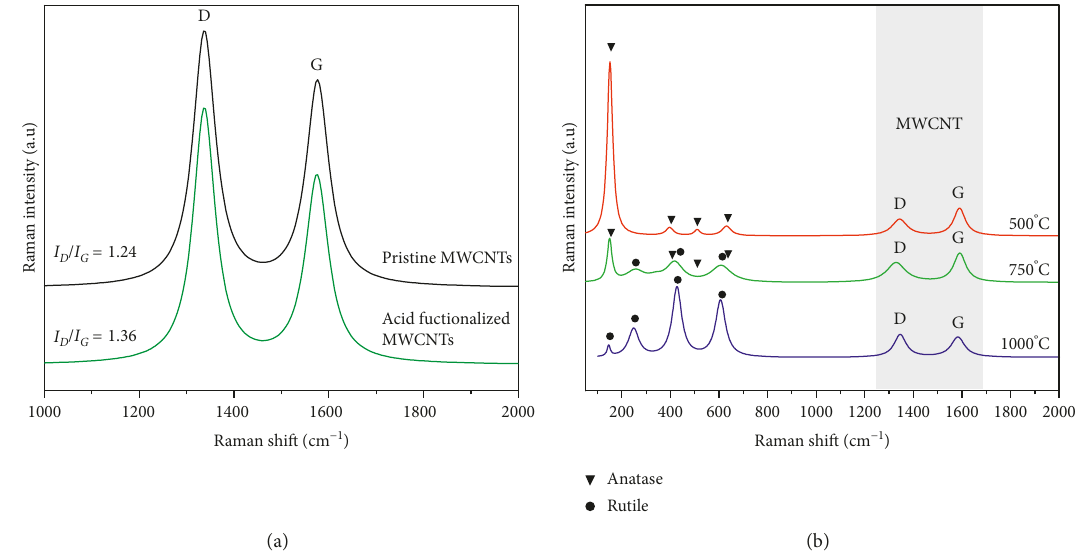
Figure 7: Raman spectra for pristine and acid functionalized MWCNTs. (b) TiO 750 ° C, and 1000 °